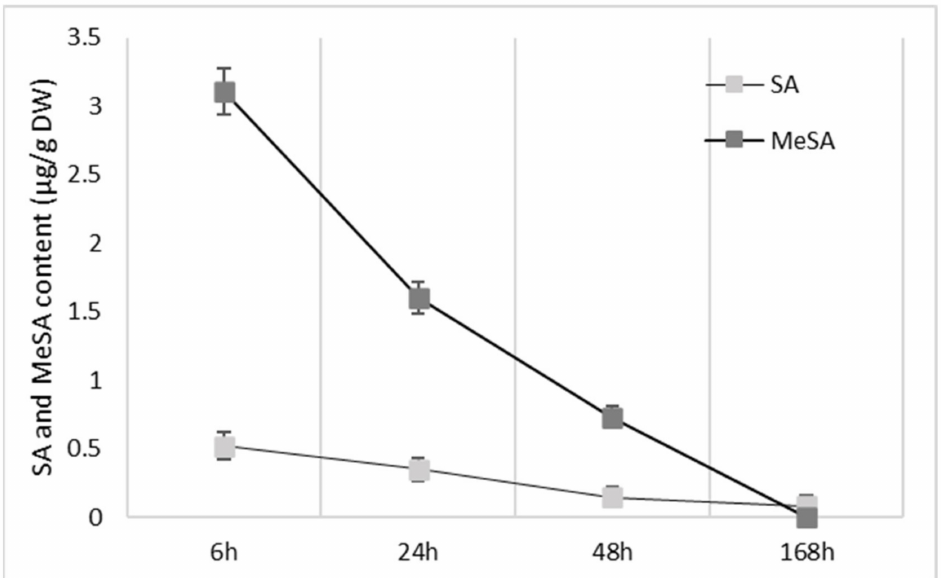
Figure 3. Content of methyl salicylic acid (MeSA) and salicylic acid (SA) in apple peel for the different sampling times after the first spraying (Spray#1). Data are means ± standard error ( n = 10). DW, dry